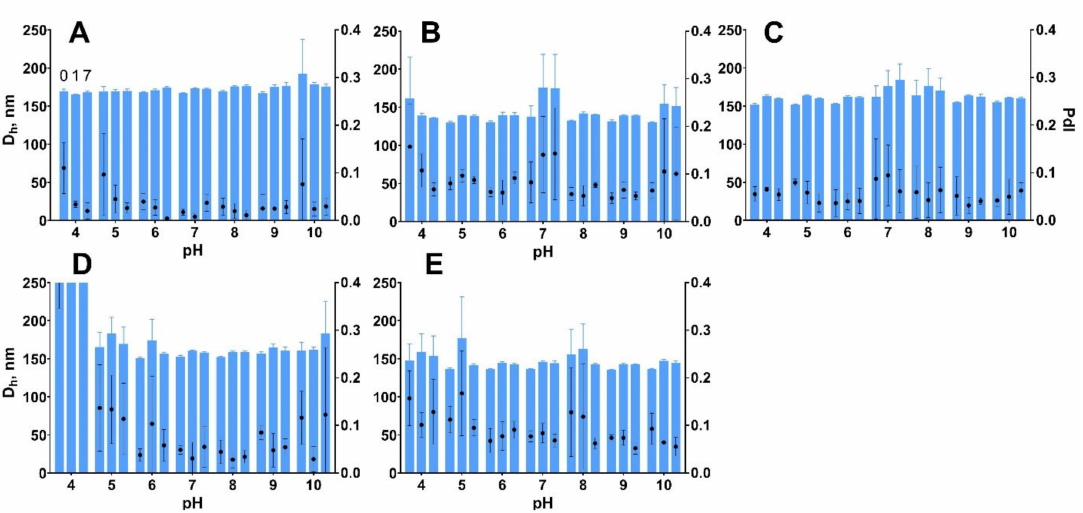
Figure 6. Colloidal stability of gelatin nanoparticles at different pH values. ( A ) B75-1; ( B ) B225-1; ( C ) FISH-1; ( D ) A62-1; ( E ) A180-1. Dh—hydrodynamic diameter; PdI—polydispersity index. Mean values of three technical replicates are shown, mean ± SD. Measurements were performed on days 0, 1, and